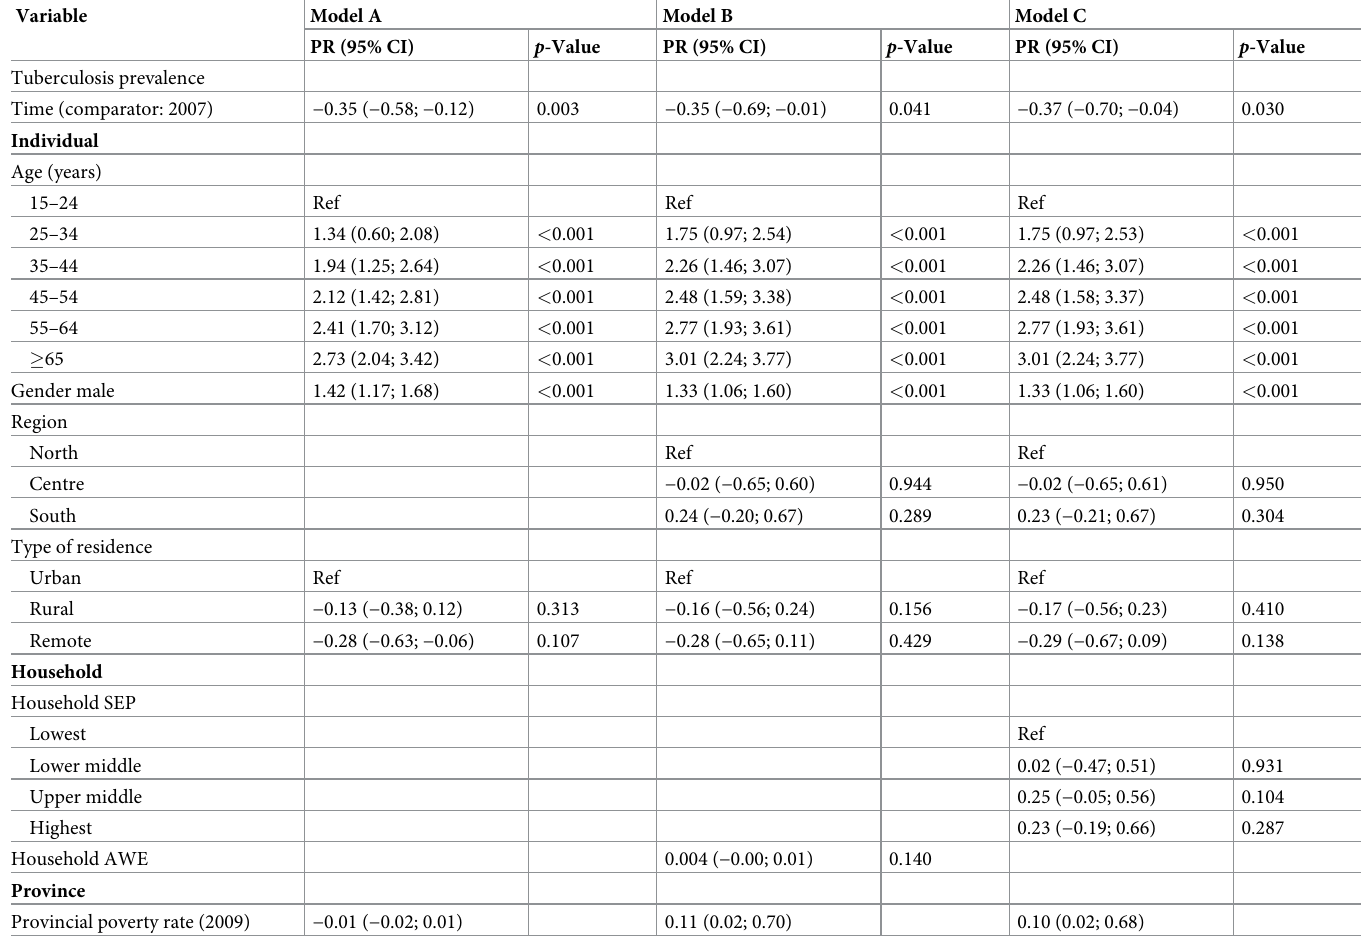
Table 3. Multilevel analyses examining associations between individual-, household-, and neighbourhood-level explanatory variables and change in tuberculosis